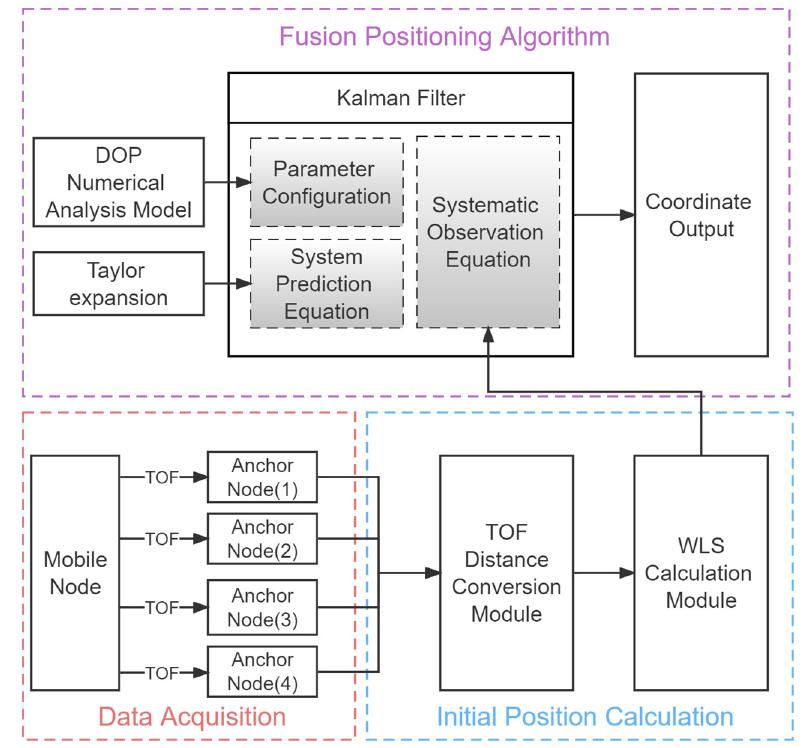
Figure 1. Framework of the positioning algorithm.